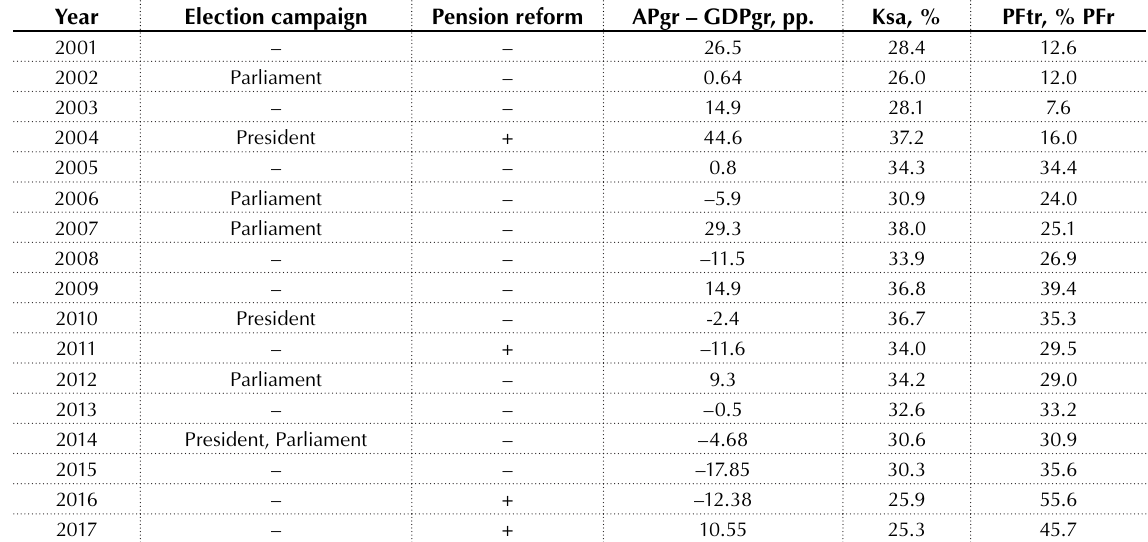
Table 3. Election campaigns, significant changes in pension legislation and economic populism indicators in